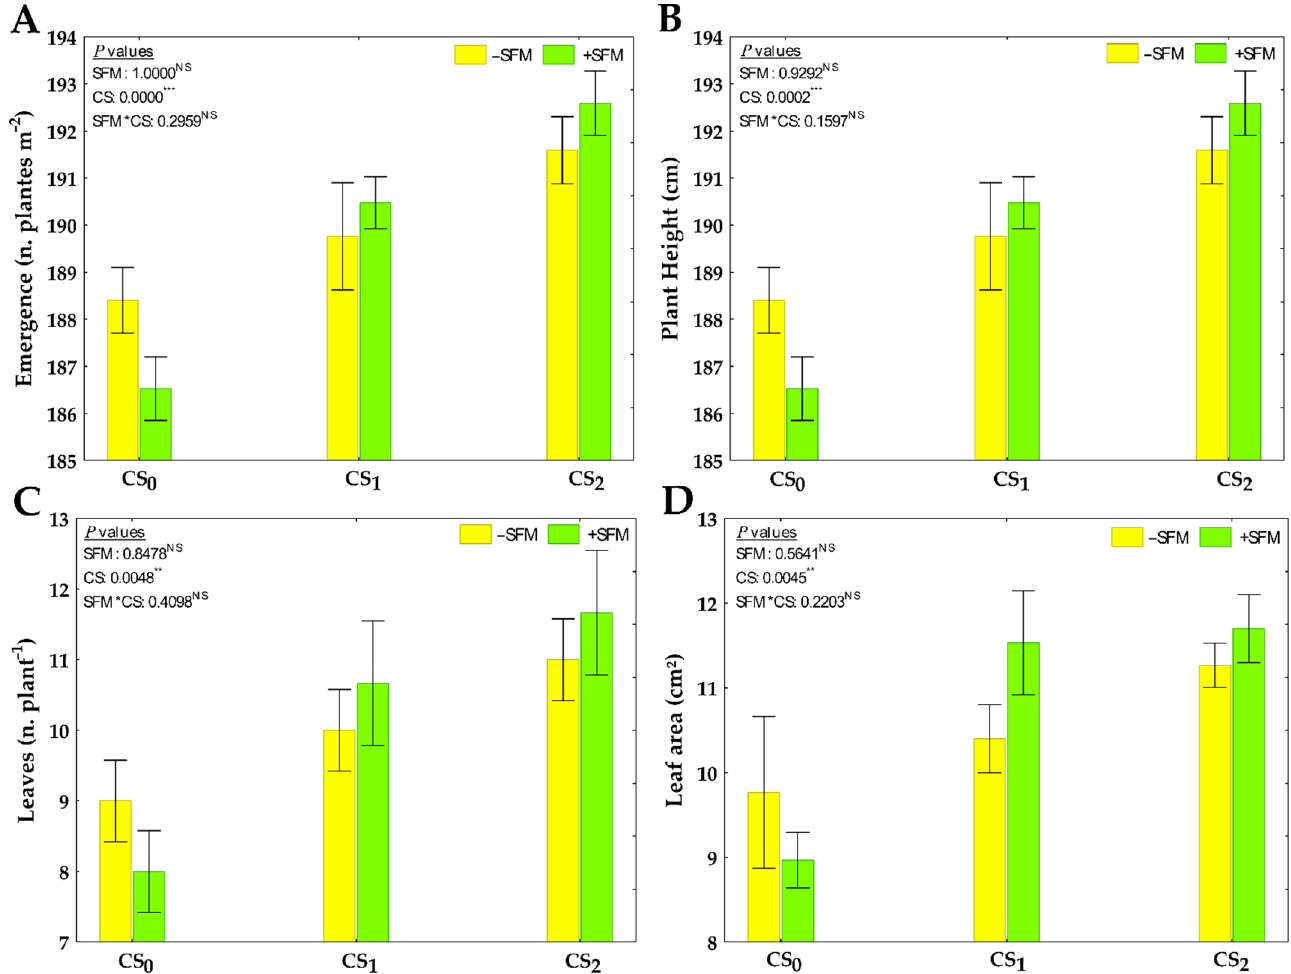
Figure 3. Plant emergence ( A ), plant height ( B ), number of leaves ( C ), and leaf area ( D ) of sweet maize, as affected by the compost source and sugarcane filter mud application. CS 0 = control treatment with no CS input; CS 1 = crop residues (brassica residue); CS 2 = domestic wastes (household waste); − SFM = sugarcane filter mud not applied; +SFM = sugarcane filter mud applied. Bars represent ± SE ( n = 3). ** 0.001 < p ≤ 0.01, *** p ≤ 0.001; NS: not significant.